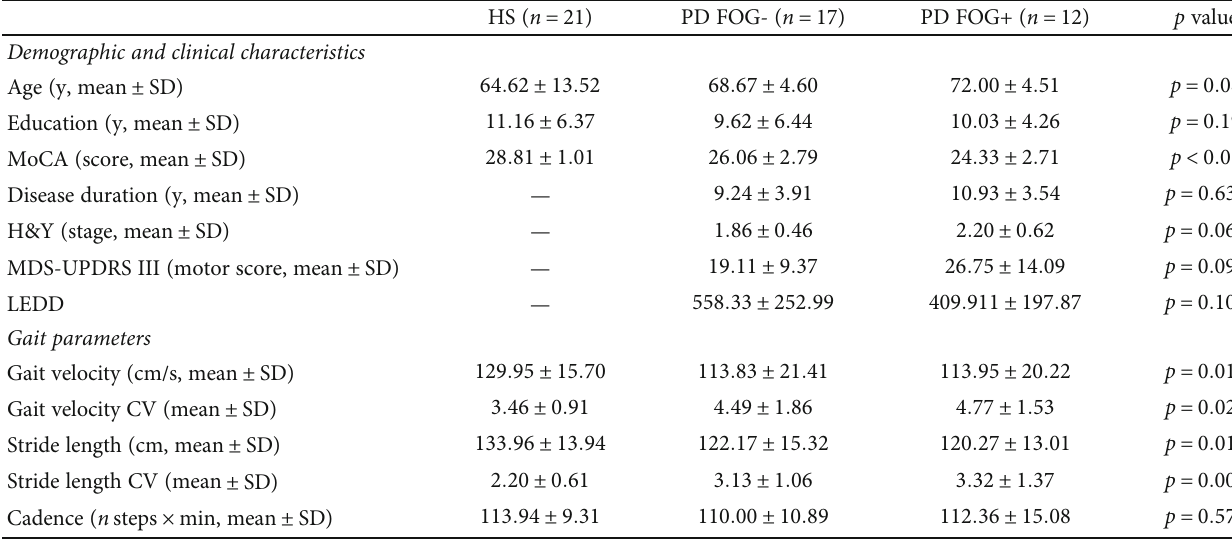
Figure 1: Gait assessment protocol. PD participants walk at their comfortable speed on GAITRite® for 1 minute. Table 1: Demographics, clinical characteristics, and gait parameters of participants.